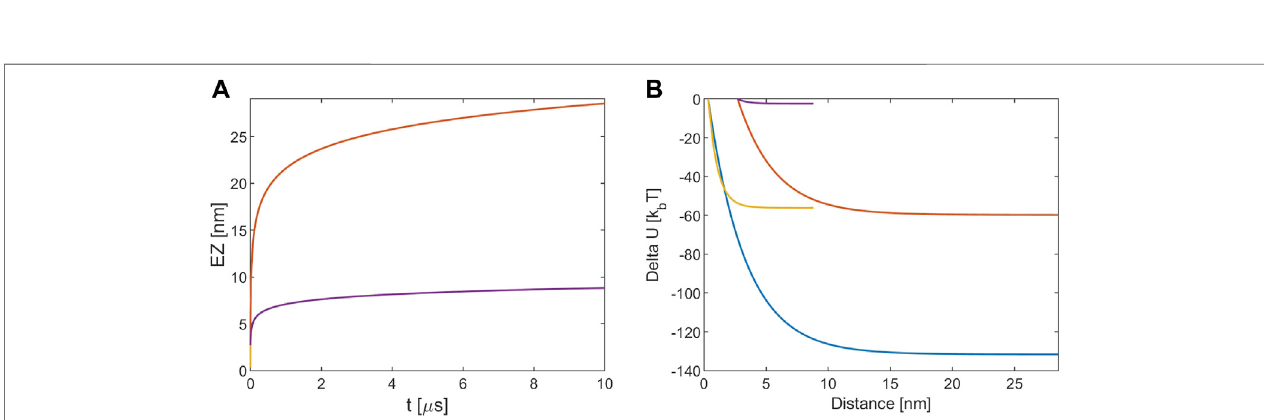
FIGURE 2 | (A) EZ between tubulin dimers. (B) Electrostatic potential energy variation. The blue and red lines refer to [KCl] = 10 mM, r (0) = R + d and r (0) = R+a, respectively.Theyellowandvioletlinesreferto[KCl]=160 mM,r(0)=R+dandr(0)=R+a,respectively.NotethatfortheEZtheblueandtheyellowlinesaremaskedby the red and violet one because processes times are almost identical.